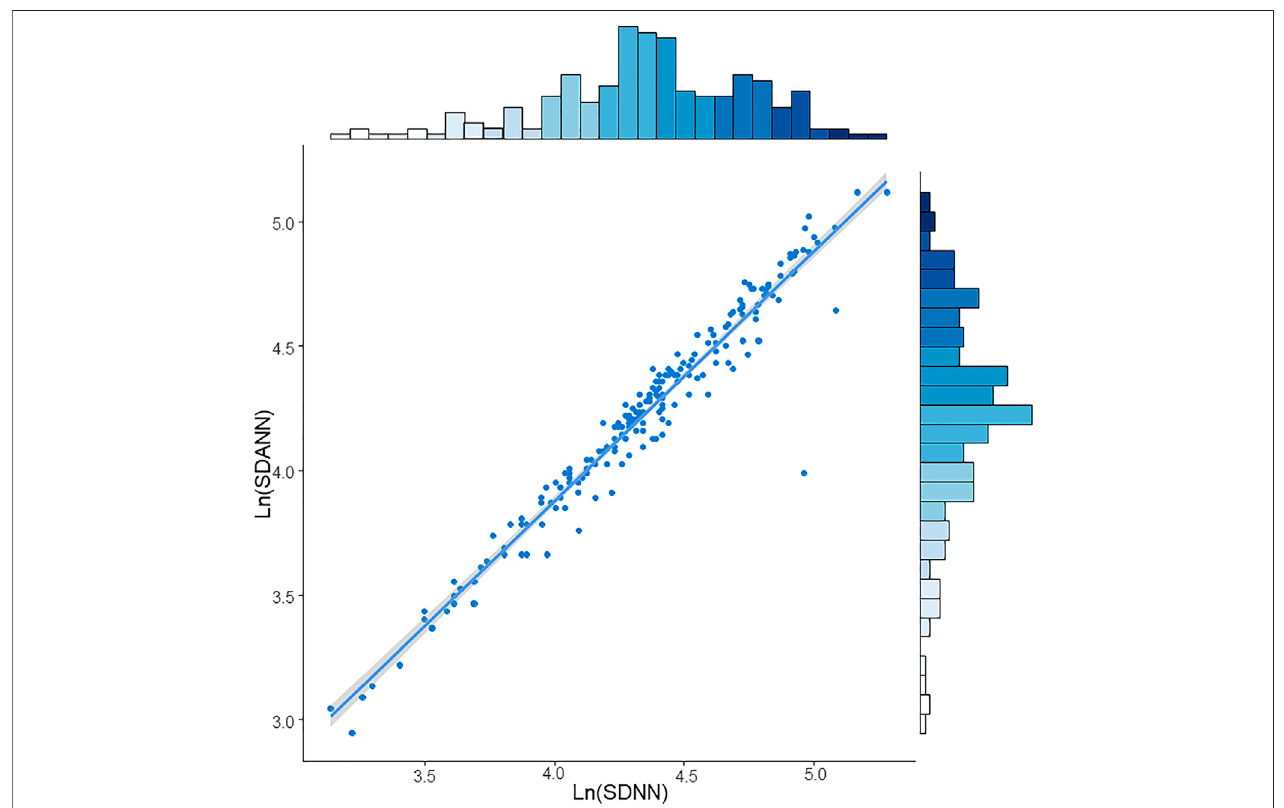
FIGURE4| Spearman ’ scorrelationbetweenLnSDNN andLnSDANN inCKD5patients.Abbreviations:SDNN,SDofnormal-to-normal R-Rintervals;SDANN,SD of 5-minute average of normal R-R intervals. CKD, chronic kidney disease.